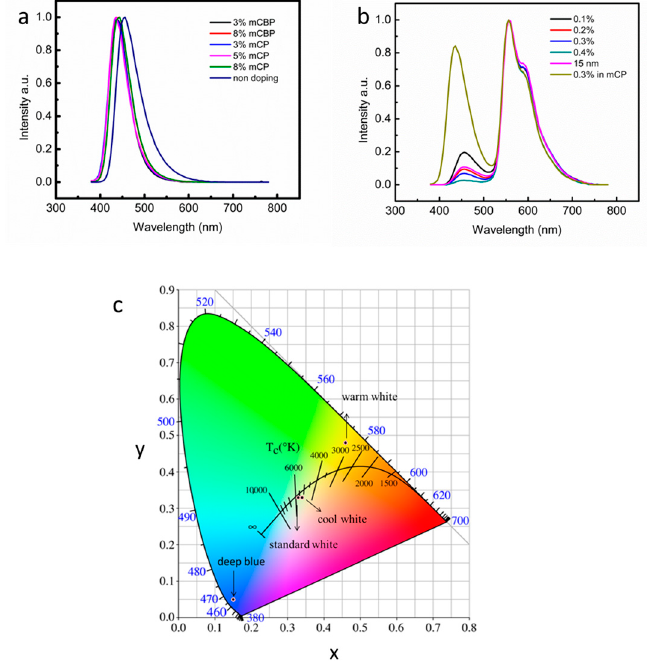
Figure 5. ( a ) EL spectra of deep-blue devices; ( b ) EL spectra of various white-emitting OLEDs; ( c ) the chromaticity coordinates of deep blue and white